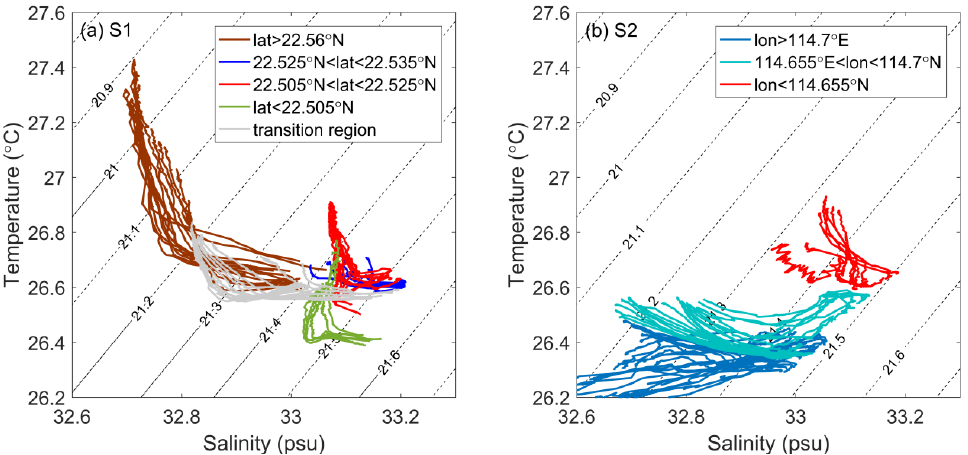
Figure 6. Temperature–salinity (T–S) diagrams for transects ( a ) S1 and ( b ) S2. Dashed lines indicate potential densities.